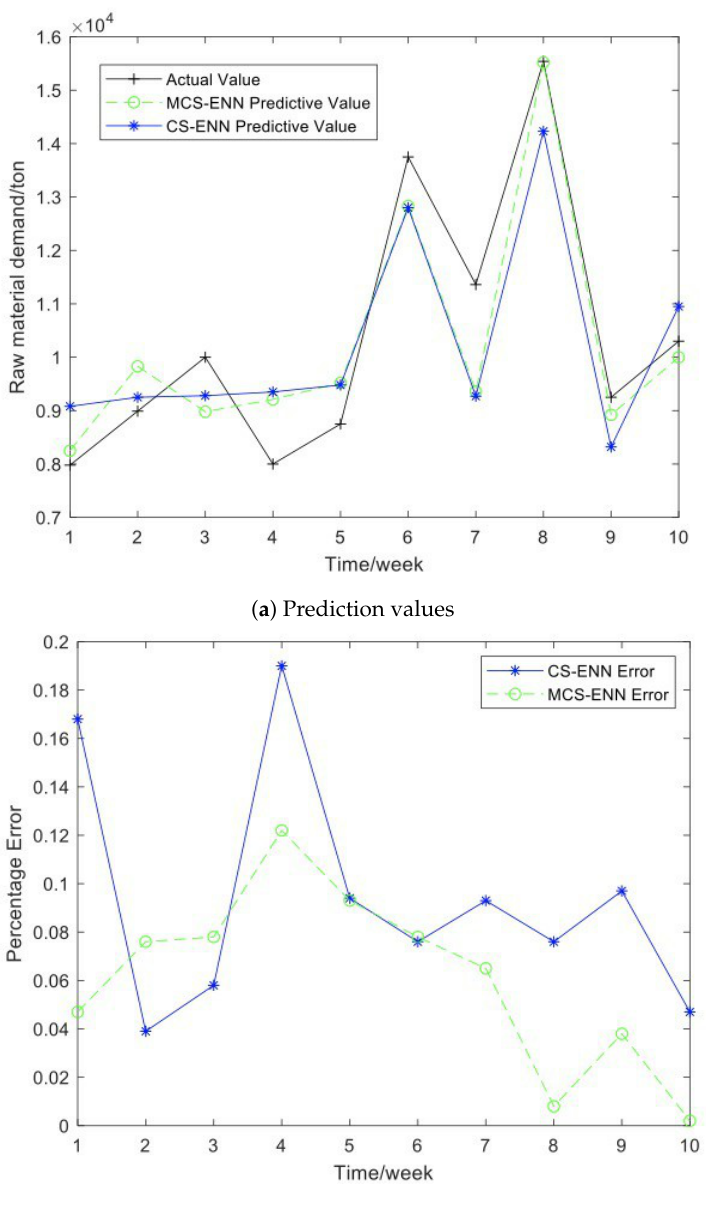
Figure 9. MCS-Elman and ENN prediction